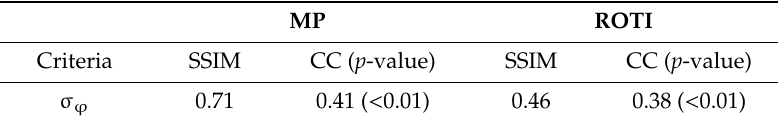
Table 16. SSIM and CC between the maps shown in Figure 15b.